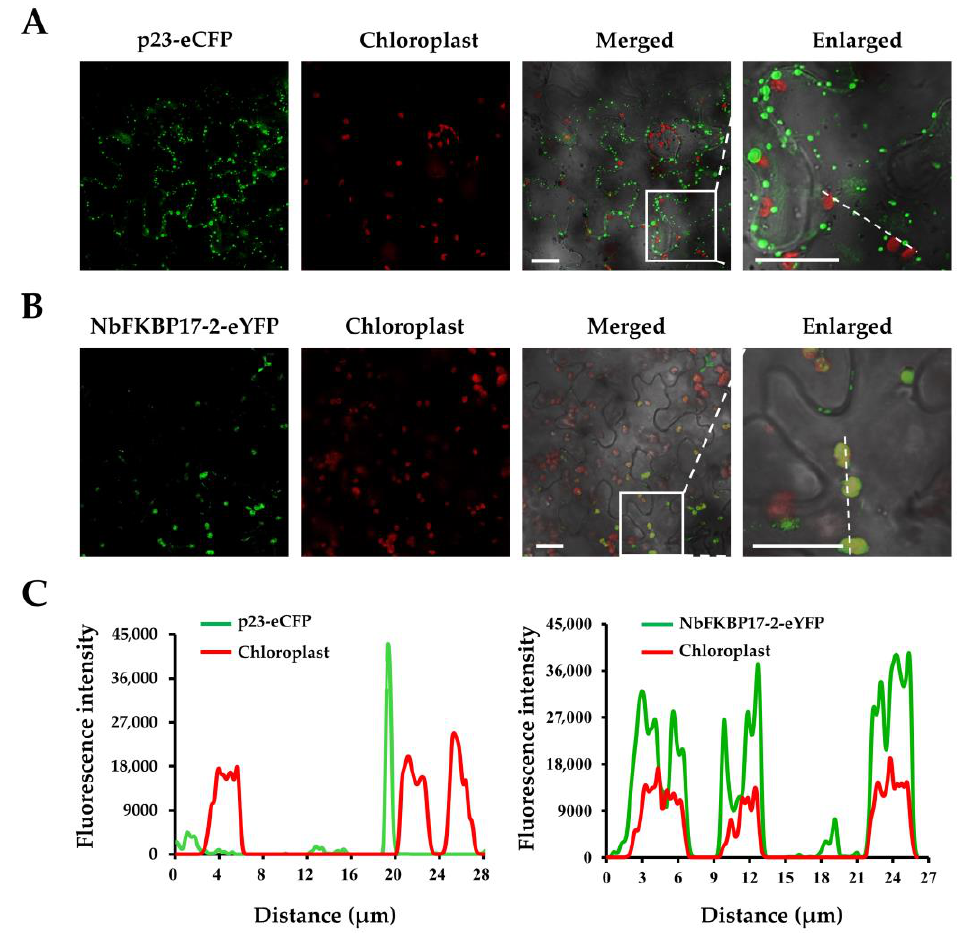
Figure 2. Subcellular localization analyses of citrus tristeza virus (CTV) p23 and NbFKBP17-2 in Nicotiana benthamiana cells. ( A ) Localization of CTV p23 and chloroplasts. The red signals represented the autofluorescent signals of chlorophyll in chloroplasts. ( B ) Localization of NbFKBP17-2 and chloroplasts. Confocal images were taken at 48 hpi. Bars, 20 μm. ( C ) The co-localization was further analyzed by overlapping fluorescence spectra, and areas indicated with white dotted lines in enlarged sections of ( A , B ) were used for this analysis.